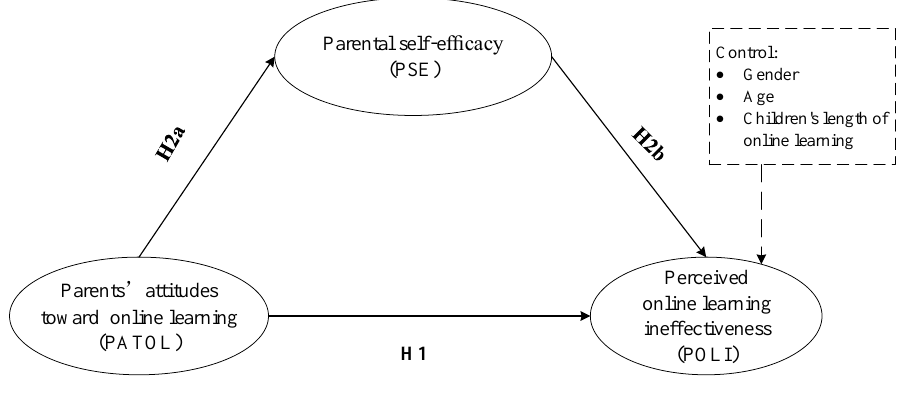
Figure 1. Hypothesized conceptual model.